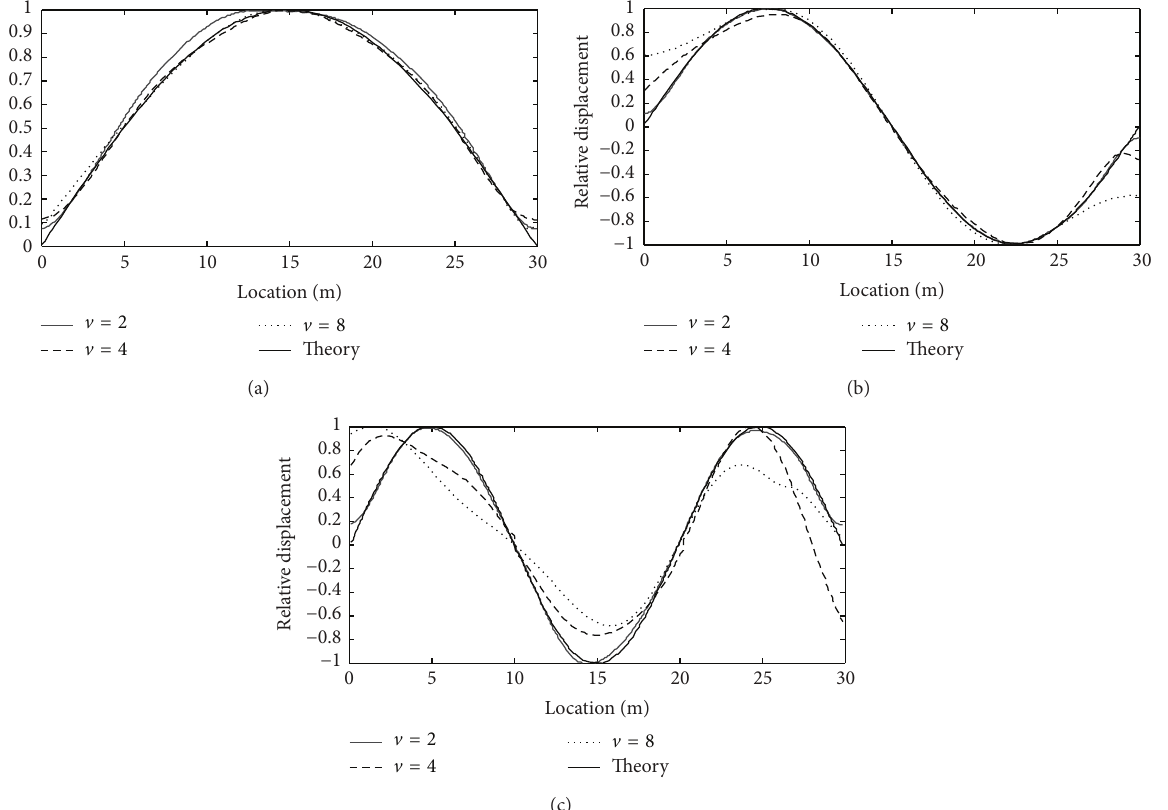
Figure 7: Mode shapes of the bridge obtained for different vehicle speeds ( V , m/s) compared with theoretical result (theory): (a) 1st mode, (b) 2nd mode, and (c) 3rd mode, after